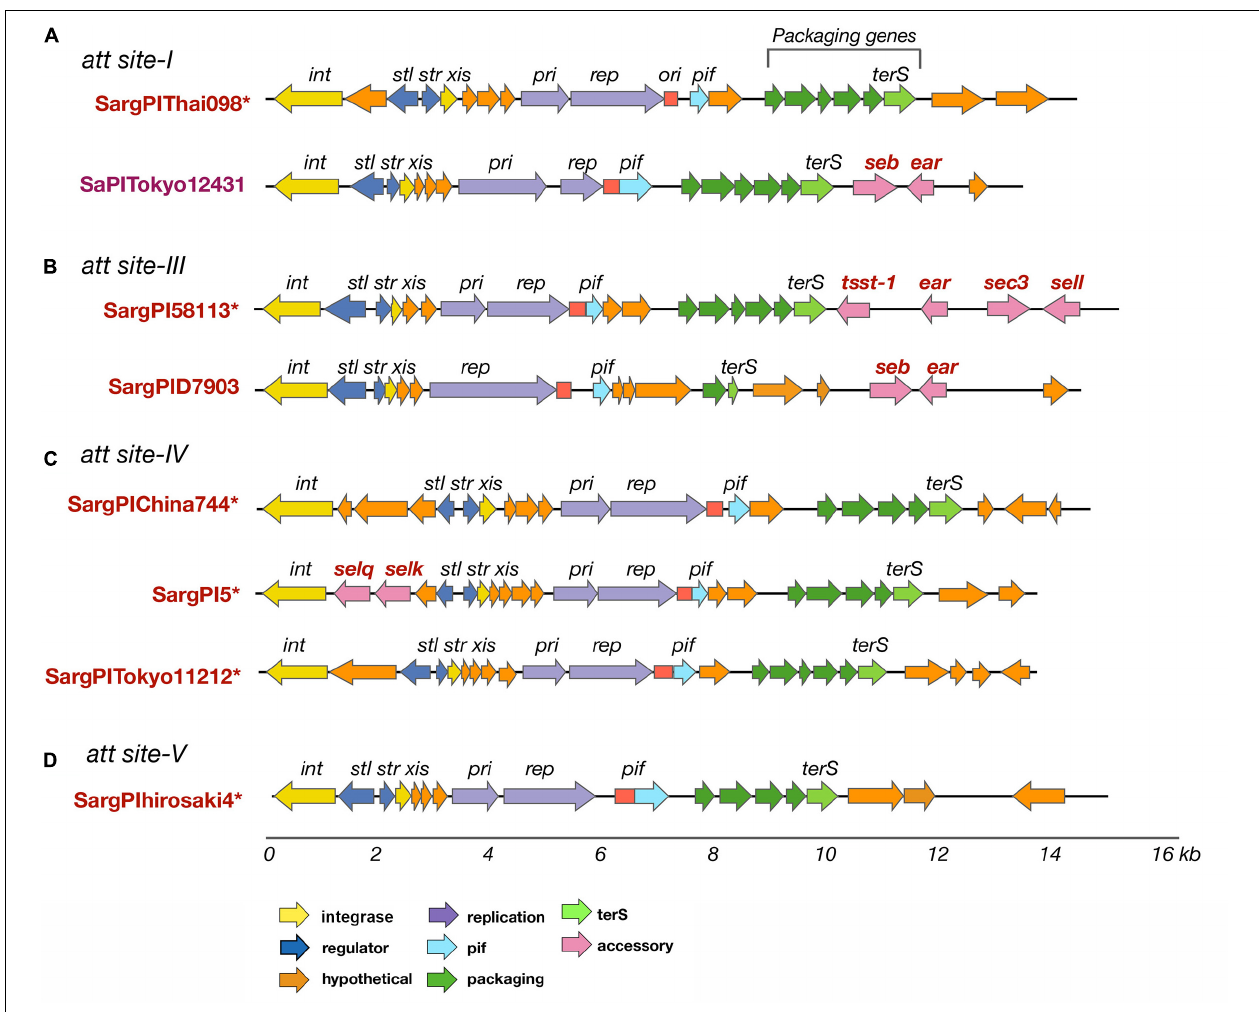
FIGURE 5 | SargPI elements found at different attachment sites in S. argenteus isolates. SargPI elements at the different attachment sites are shown in panels (A–D) . * indicates a novel SargPI found within our isolates. Genes int and xis (in yellow) are excisionase; str and stl (dark blue) are transcription regulators; pri and rep (purple) are replication genes; ori (red) is replication origin; terS (light green) is terminase with other packaging genes (dark green); ear, seb, sec3, sei, selq, selk, sem, and tsst-1 (pink) are super-antigens; pif (light blue) phage interference gene and hypothetical genes are in orange. The color of the genes is as shown for SaPIs [22] for easy comparison. The lower scale shows size of the SargPIs in